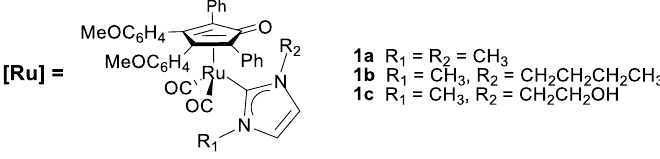
Figure 1. Cyclopentadienone NHC ruthenium(0) complexes 1a – c .